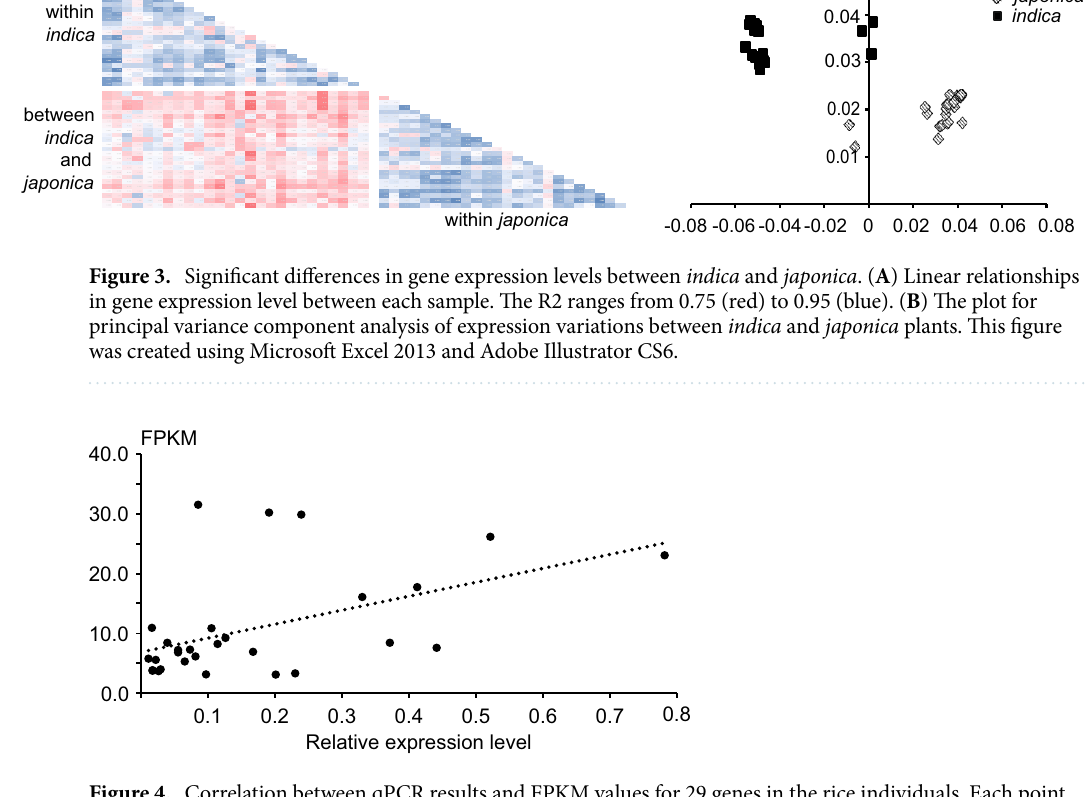
Figure 4. Correlation between qPCR results and FPKM values for 29 genes in the rice individuals. Each point represents the relative expression level of a gene. This figure was created in Microsoft Excel 2013 and Adobe Illustrator